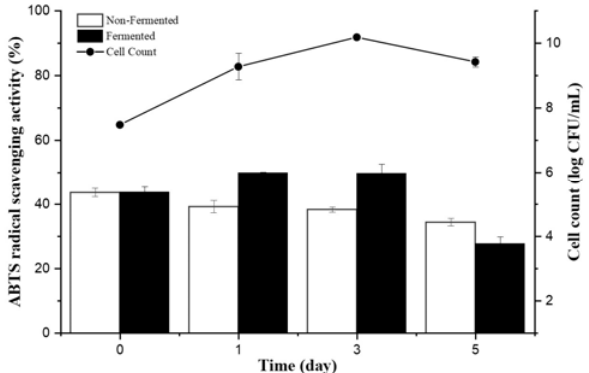
Figure 2. A 3D bubble plot of the primary selection of strains for the fermentation of Abelmoschus manihot , with a qualified presumption of safety (QPS) status among Bacillaceae species with extra ‐ cellular protease and amylase activity. Blue circle: a group of 47 strains selected for primary fermen ‐ tation. Values on the X ‐ axis indicate amylase activity, the Y ‐ axis is protease activity, and the Z ‐ axis is the QPS status of the strains. Hydrolase (protease and amylase) enzyme activities were deter ‐ mined based on the agar diffusion method. The activity of the enzymes was measured based on the radius of the halo zone around colonies (+++: >7 mm, ++: 4–6 mm, +: 1–3 mm, ‐ : no activity). Strains with a QPS status are labeled as 1 and other strains are labeled as 0.